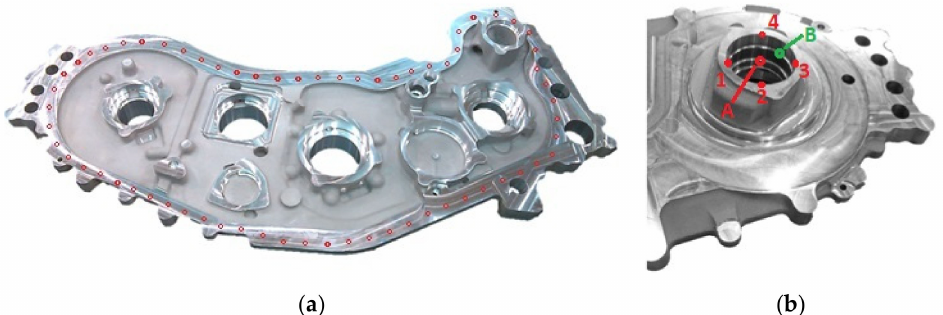
Figure 7. Cover after machining with distribution of measuring points. ( a ) Base face of the cover with marked measuring points used to determine the curvature of the surface. ( b ) Bearing seat with four measuring points used to determine, among others, the center of the hole (point A). Point B is the nominal position of the hole. Hole position deviation is the distance between points A and